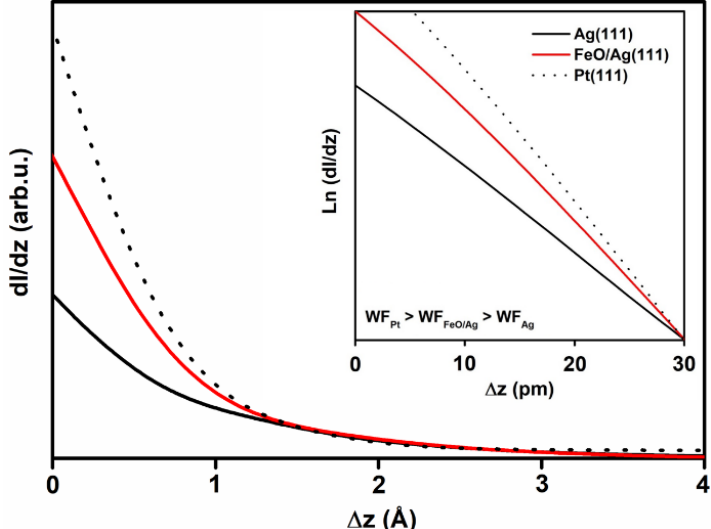
Figure 5. dI/dz curves obtained from clean Ag(111) (black solid curve), clean Pt(111) (black dotted curve) and the reconstruction-free islands grown by Fe deposition onto a Ag(111) substrate kept at 550 K and post-oxidation (red curve). The inset presents the slopes of the curves plotted in a logarithmic scale.